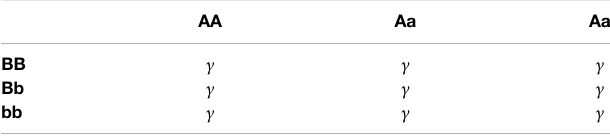
TABLE1| Tableofoddsforthenoeffectmodelwithoutinteractionbetweenapair of